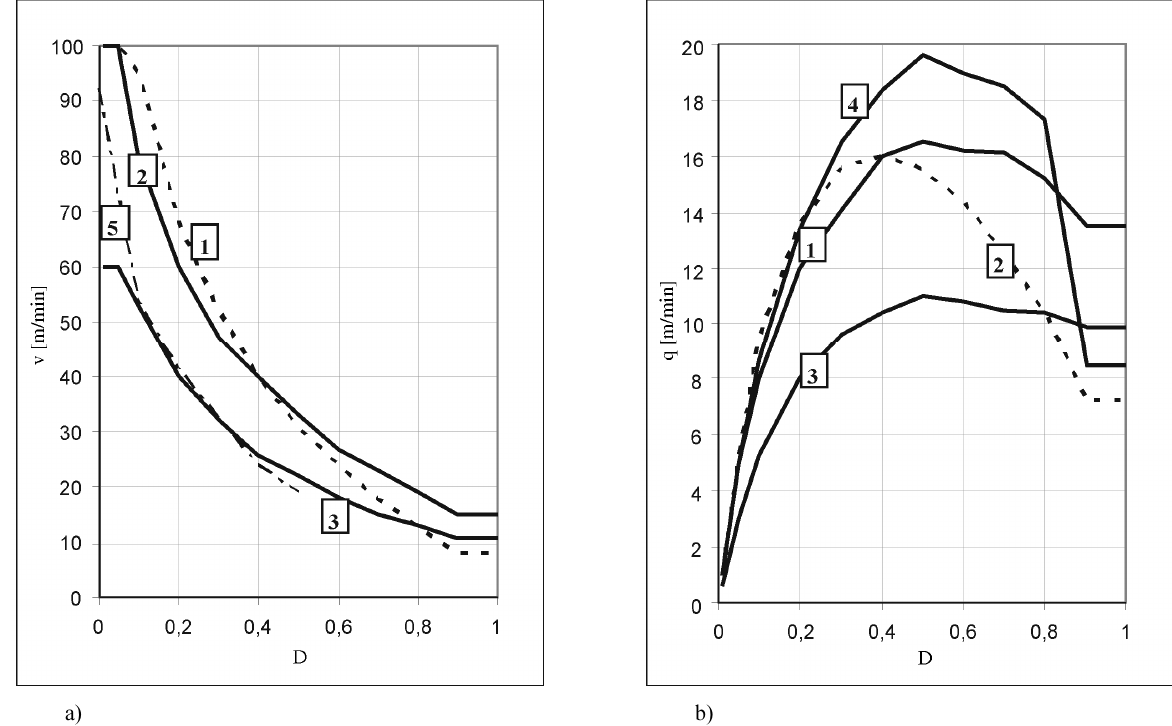
Fig. 1. People movement speed versus evacuation stream type and density: 1 – horizontal movement; 2 – down; 3 – up; 4 – through openings and doors, 5 –